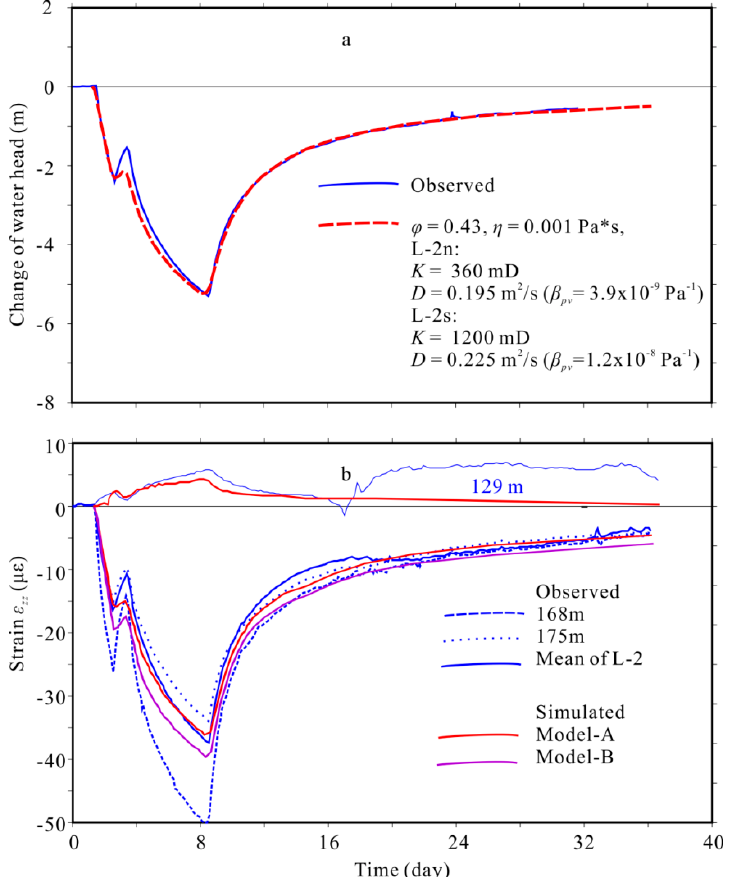
Figure 9. Observed and simulated ( a ) water head and ( b ) vertical strain ( ε zz ). Both the water head and strain data were represented fairly well by the numerical